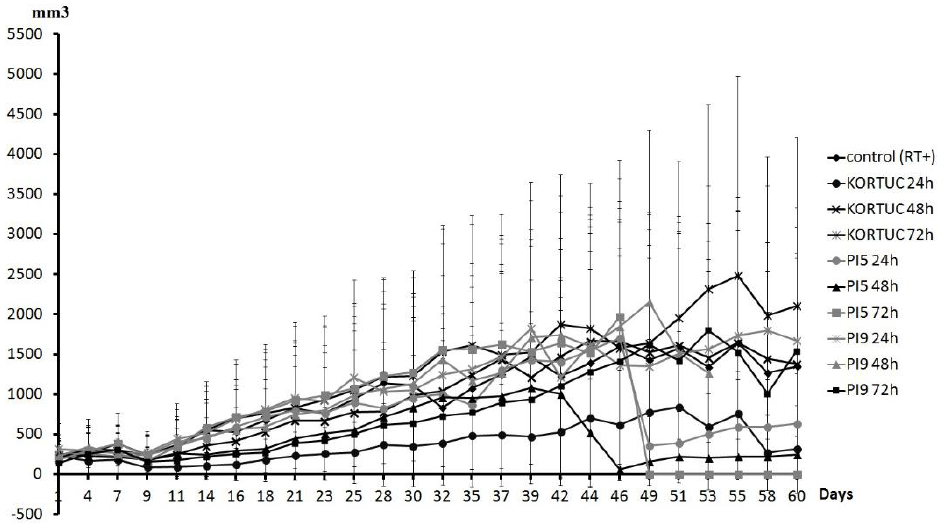
Figure 3. Tumor volume curve for all groups. Tumor growth rate was slowest in the KORTUC (24 h) group. The KORTUC (72 h) group did not show an inhibitory effect on tumor growth rate. During the observation period, complete resolution of tumors occurred in each group. Mice in which the tumors had disappeared on day 60 included: three mice in the KORTUC (24 h) group and one mouse each in the PI5 (72 h) and PI9 (72 h) groups.